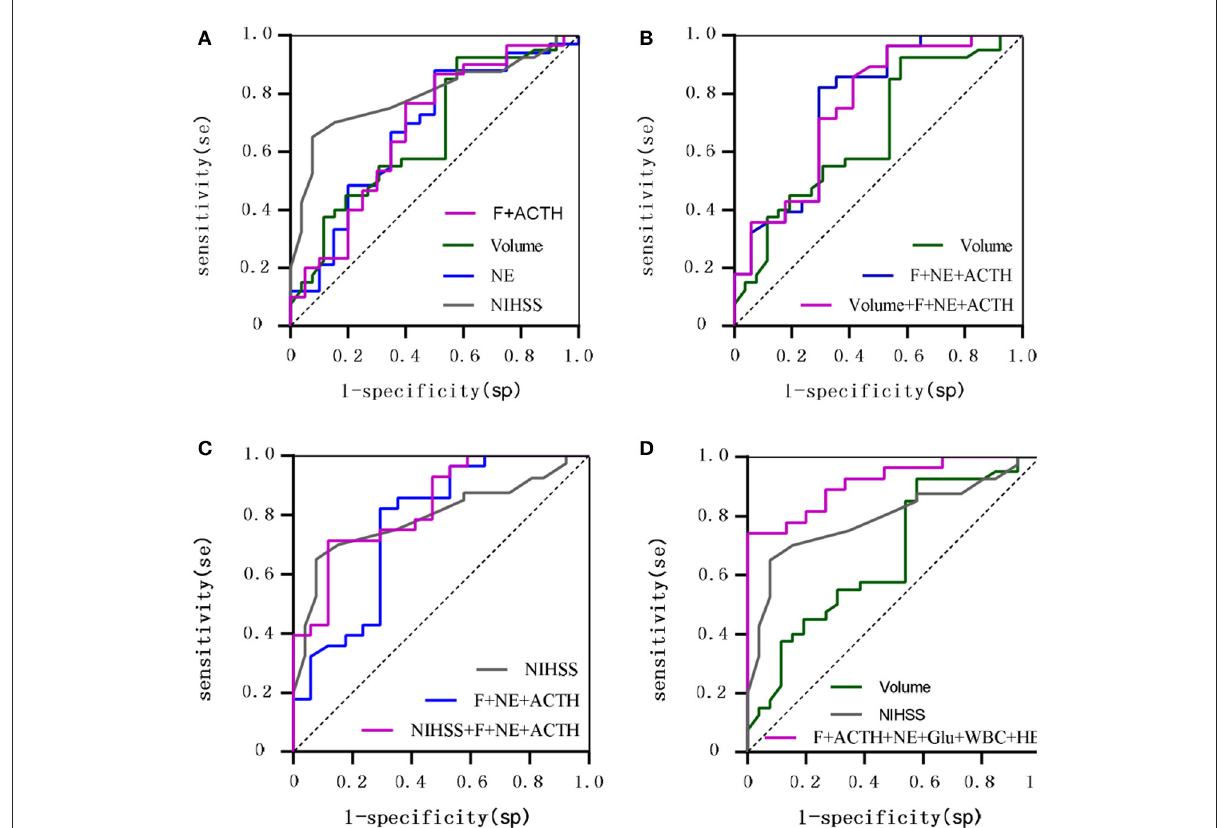
FIGURE3 ROC curves comparing the value of hormones vs. traditional clinical variables for 90-day prognostic assessment. (A) Shows F combined with ACTH, NE, Lesion volume, NIHSS; (B) Shows F combined with NE and ACTH compared with Lesion volume; (C) Shows F combined with NE and ACTH compared with NIHSS; (D) Shows F combined with ACTH and NE and Glu and WBC and HB compared with Lesion volume,